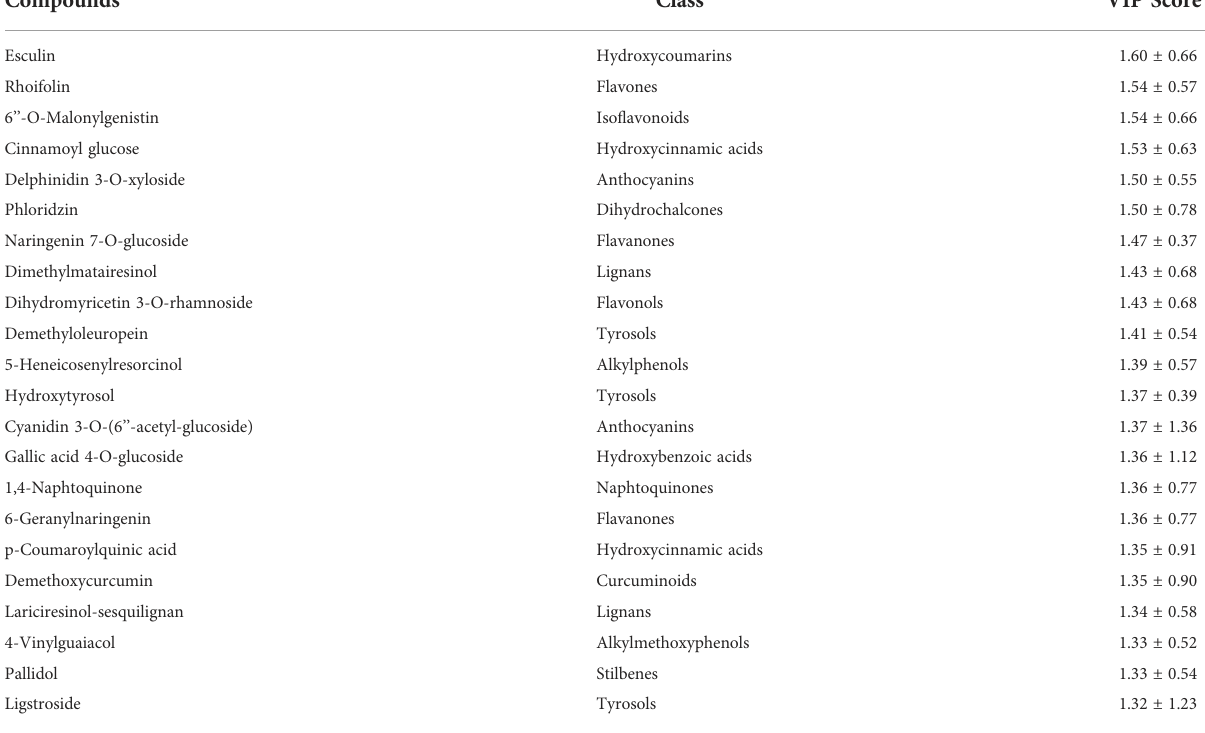
TABLE 1 Discriminant metabolites identi fi ed as VIP markers selected from the OPLS-DA model performed for the elicitation of BD PCSCs.